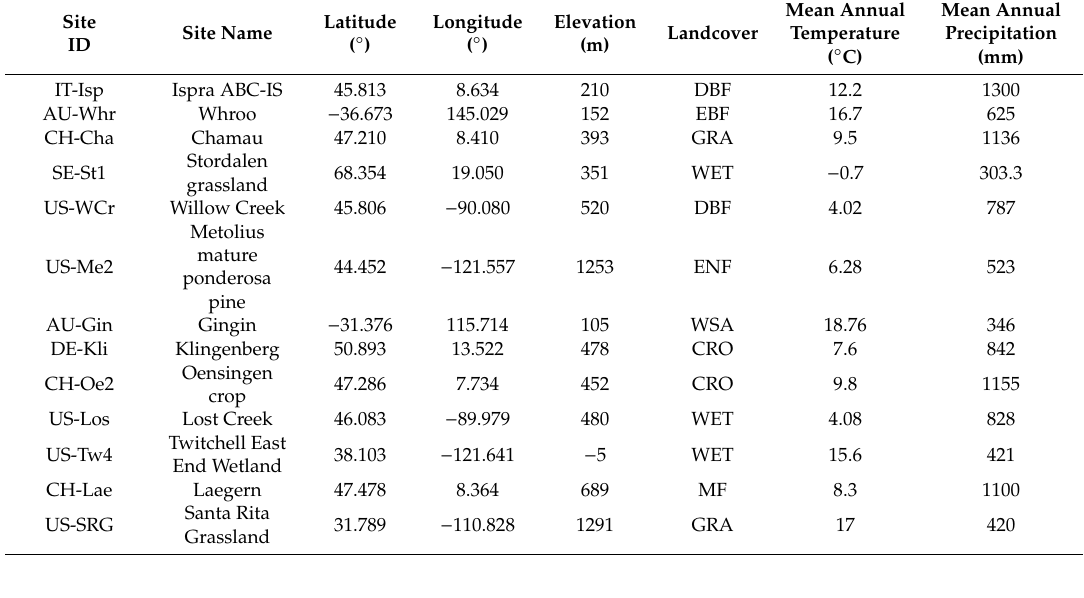
Table 4. Detailed information for a few sites.